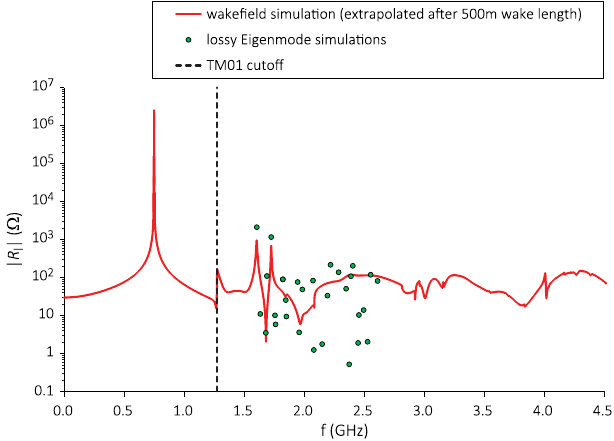
2.FIG. 8. Cavity monopole impedance spectra (solid line denotes wakefield calculation with beam traversing along the axis; green dots denote complex Eigenmode computations, either mode polarization). Note that the accelerating mode is not resolved in the wakefield simulation. The external Q is dominated by the FPC